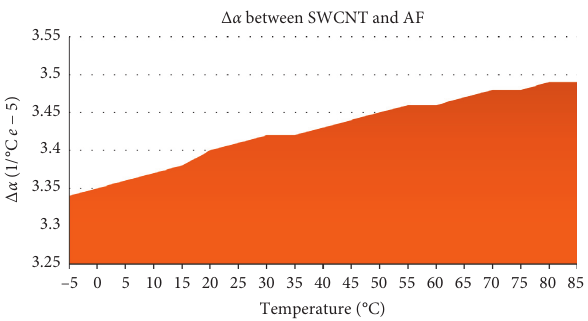
Figure 2: Mismatch between the CTEs of SWCNTand AF ( Δ α ) in temperature range of − 5 to 85 ° C within the SWCNTAF.